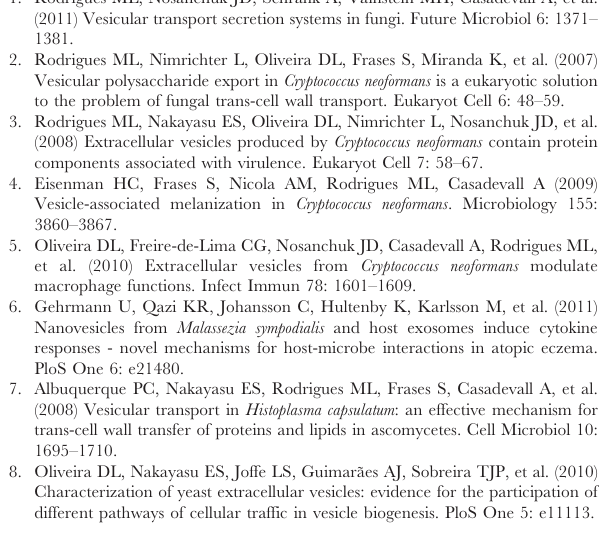
dissociation (PQD), and spectra were annotated manually. GroP, glycerophosphate; Ser, serine. (TIF) Figure S5 Tandem-MS spectrum of a major phosphati- dylinositol (PI) species (C16:0/C18:2-PI). Samples were dissolved in methanol, containing 0.05% FA, 0.05% NH 4 OH, and analyzed by ESI-MS/MS ion in the negative-ion mode. Fragmentation was performed by total-ion mapping using pulsed-Q dissociation (PQD), and spectra were annotated manually. GroP, glycerophosphate; InsP, phosphoinositol. (TIF) Figure S6 Tandem-MS spectrum of a major phosphati- dylglycerol (PG) species (C16:0/C18:1-PG). Samples were dissolved in methanol, containing 0.05% FA, 0.05% NH 4 OH, and analyzed by ESI-MS/MS in the negative-ion mode. Fragmenta- tion was carried out by total-ion mapping using pulsed-Q dissociation (PQD), and spectra were annotated manually. GroP, glycerophosphate. (TIF) Figure S7 Tandem-MS spectrum of a major phosphatidic acid (PA) species (C18:2/C18:1-PA). Samples were dissolved in methanol, containing 0.05% FA, 0.05% NH 4 OH, and analyzed by ESI-MS/MS in the negative-ion mode. Fragmentation was carried out by total-ion mapping using pulsed-Q dissociation (PQD), and spectra were annotated manually. GroP, glycerophosphate.